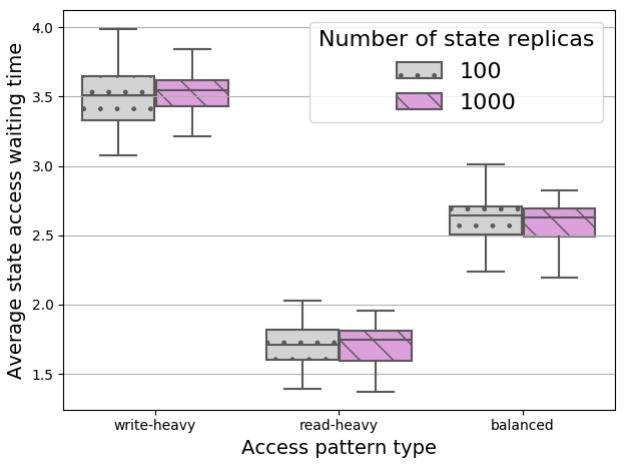
Figure 7. Access delay results of the proposed placement in the case of different state access patterns and number of state